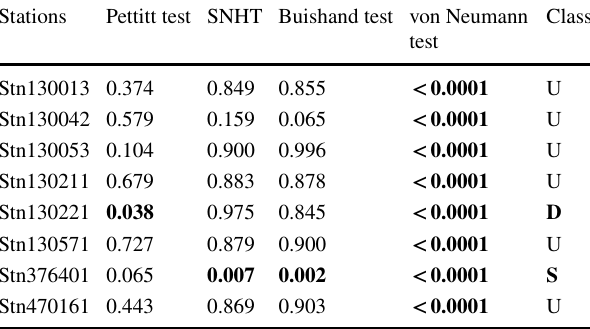
Table 8 The p values obtained from the homogeneity tests for the monthly rainfall series during 1971–2015